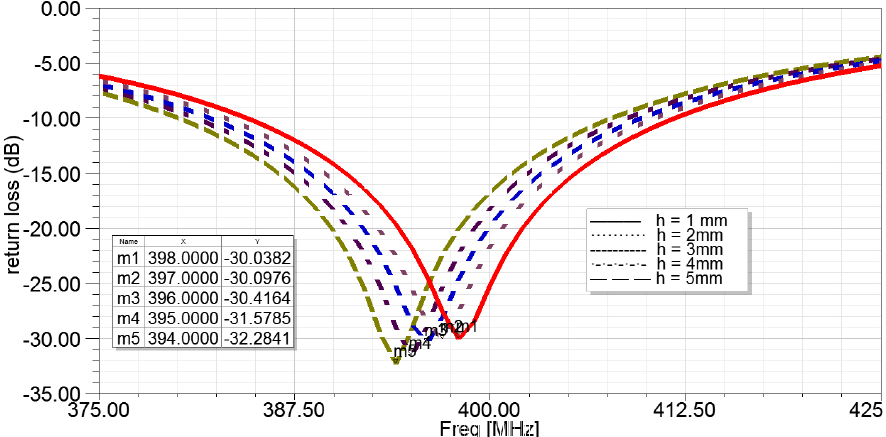
Figure 11. The return losses of the antenna with different values of height (h) of the SMA connector.